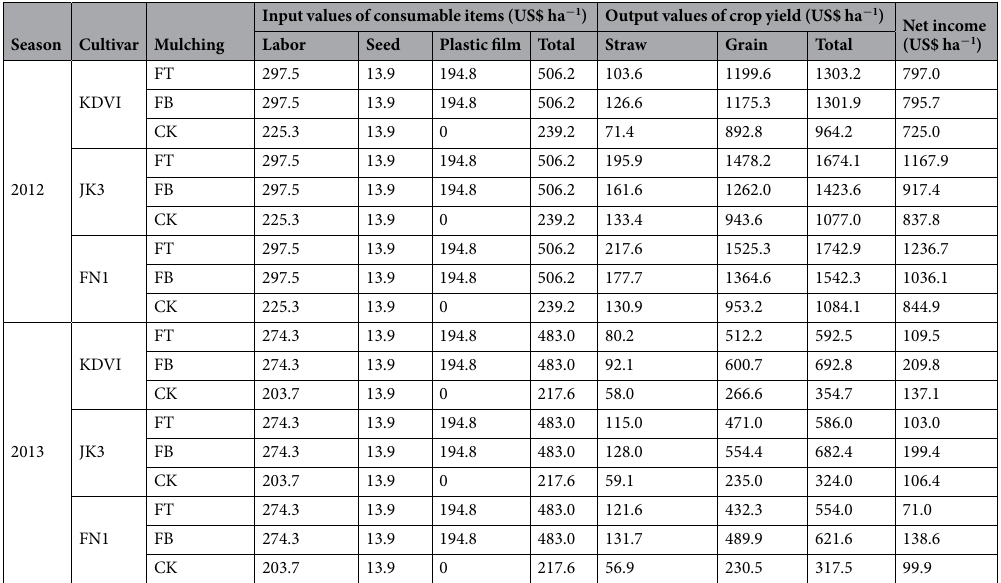
season. Importantly, the technologies had the advantages of simple operation, low cost and efficient output, and can be widely recognized by local farmers. We had also conducted technology demonstration and application at farmer household scale in Juja, Machakos and other counties of Kenya, which was widely adopted by local farm- ers. For example, in a village around Juja County (10 km northwest to Juja), we completed the technology applica-